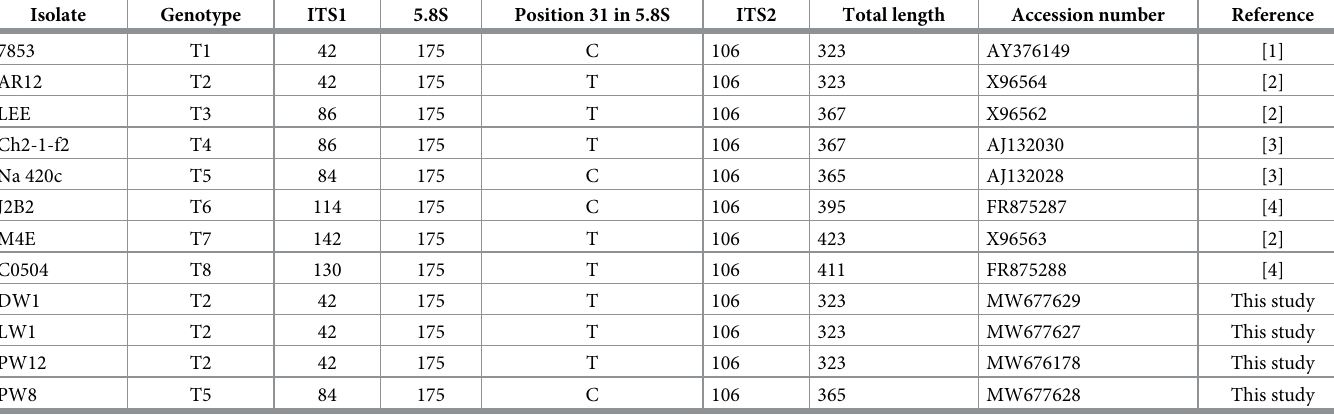
Table 5. Base length and position of ITS1, ITS2 and 5.8S rRNA sequences of references strains and all the positive isolates in this study.